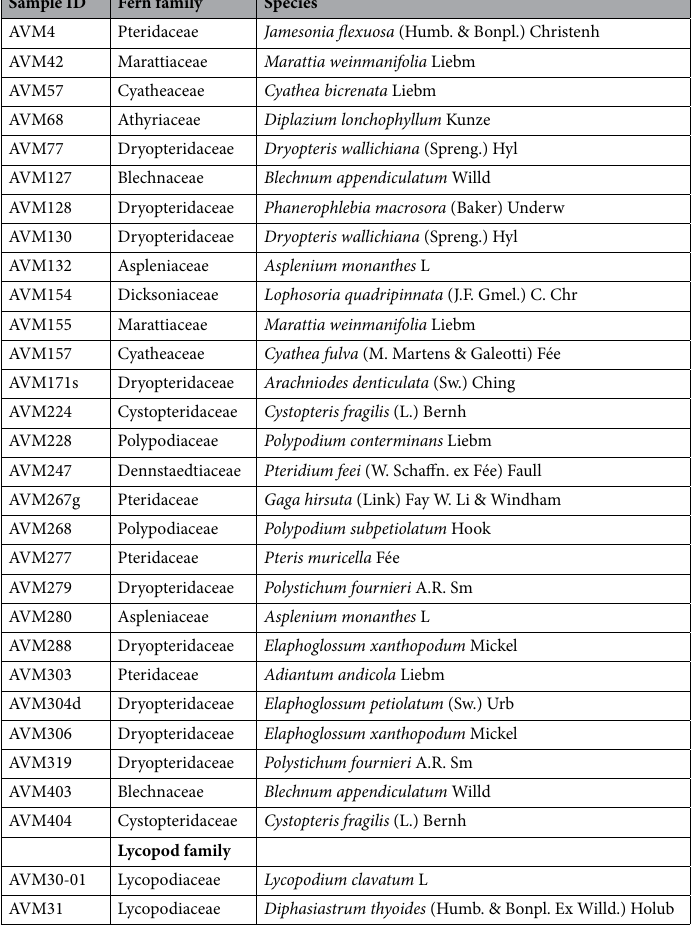
Table 2. Ferns and lycopods collected at Mixteca Alta, Oaxaca, samples’ ID, and species determination.